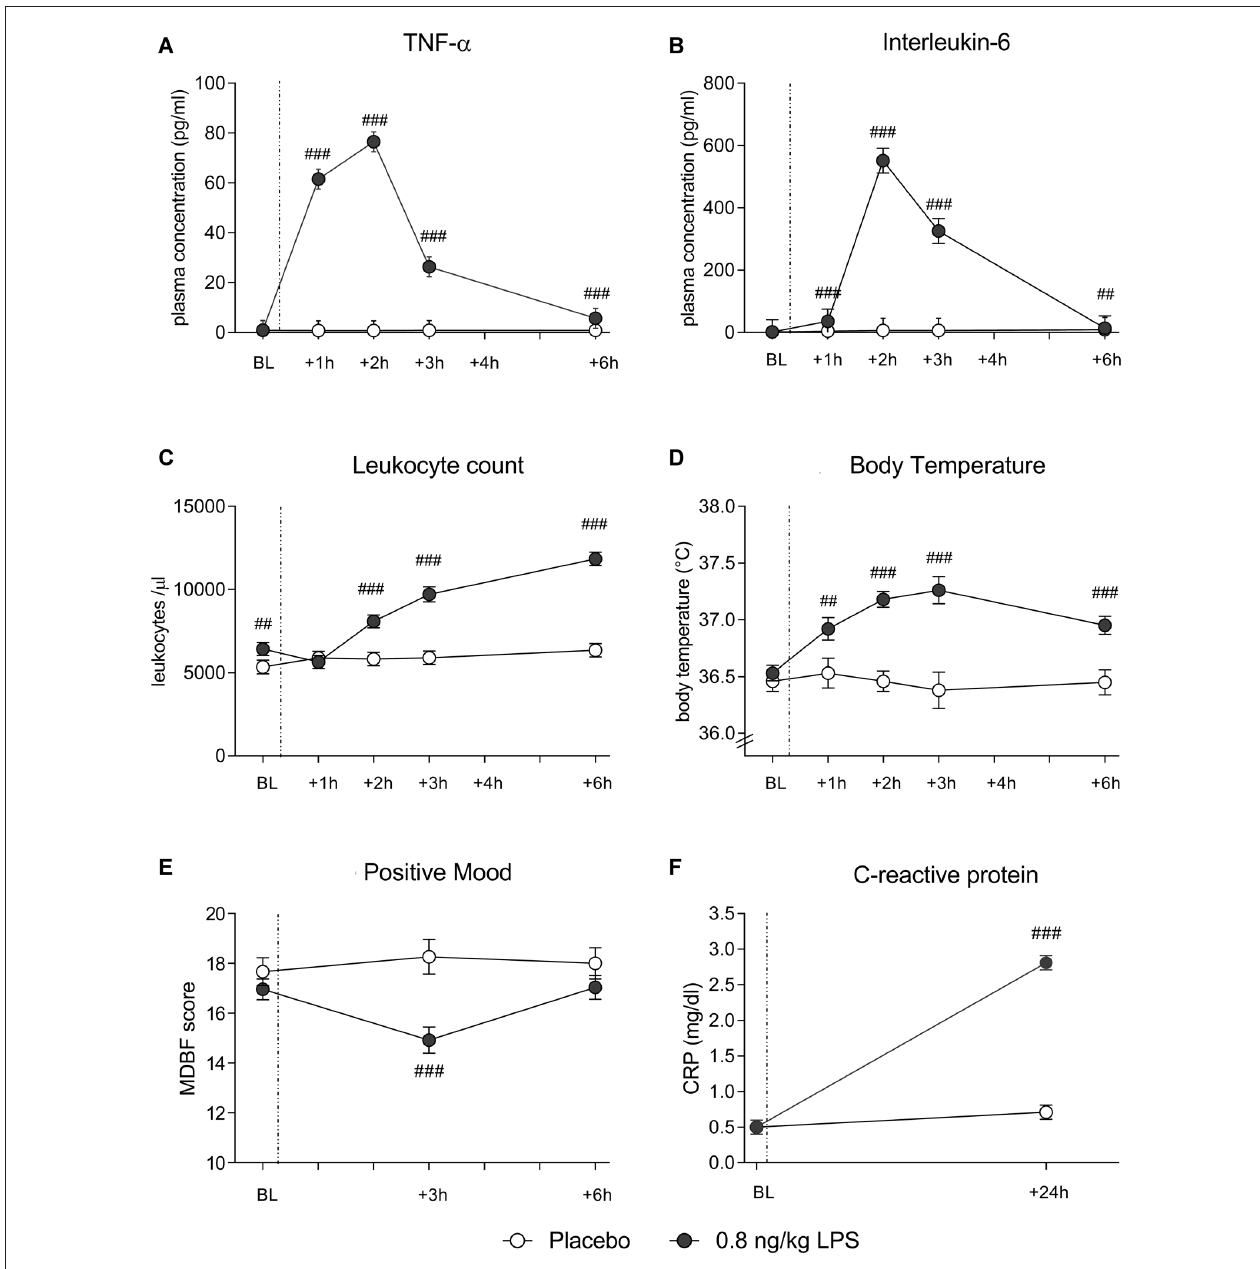
FIGURE 2 | Data set 2: plasma concentrations of TNF- α (A) and IL-6 (B) , leukocyte counts (C) and body temperature (D) were measured before (BL), and 1, 2, 3 and 6 h after injection of either 0.8 ng/kg body weight LPS (black dots) or saline (placebo group; white dots). Mood (E) was assessed with the respective subscale of the German Multi-Dimensional Mood (MDBF) questionnaire at BL, as well as 3 and 6 h after injection. CRP (F) was measured at BL and 24 h post injection. ### p < 0.001, ## p < 0.01, 0.8 ng/kg LPS group vs. placebo group. For results of repeated measures ANOVA, see text.